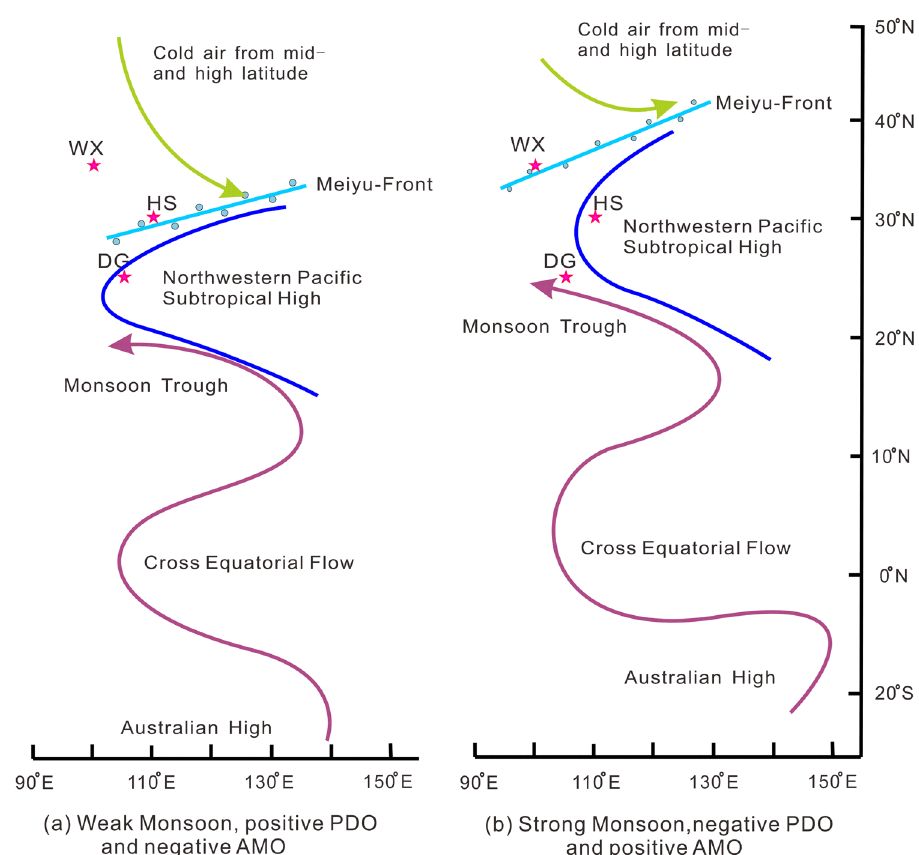
Fig. 7 Schematic diagram of the in fl uence of the Asian monsoon, PDO, and AMO on the precipitation distribution patterns in East China. a A weak monsoon with positive PDO and negative AMO. During this period, the position of the West Paci fi c subtropic High (WPSH) was southward and Central China (HS) is controlled by Meiyu front with rich rainfall, while South China (DG) and North China (WX) with less rainfall, presenting as a tripole pattern ( ‘ − / + / − ’ ). b A strong monsoon with negative PDO and positive AMO. During this period, the position of the WPSH was northward, which covered Central China (HS) with less rainfall, while South China (DG) and North China (WX) were controlled by monsoon trough and Meiyu front with rich rainfall, presenting an anti-tropile rainfall pattern ( ‘ + / − / + ’ ). This diagram is drawn according to refs. 55,56